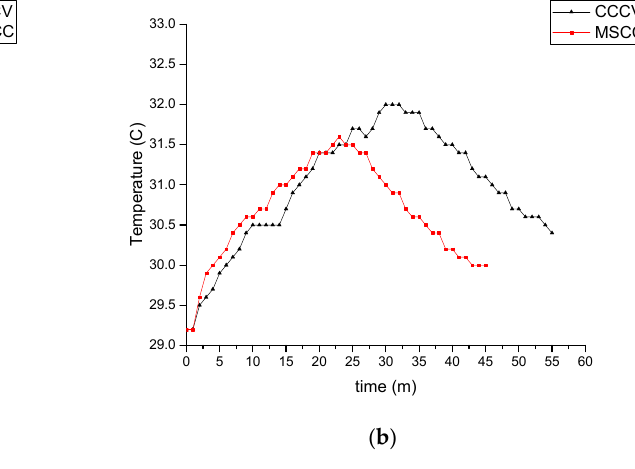
Figure 13. Battery temperature: ( a ) 2S; ( b )